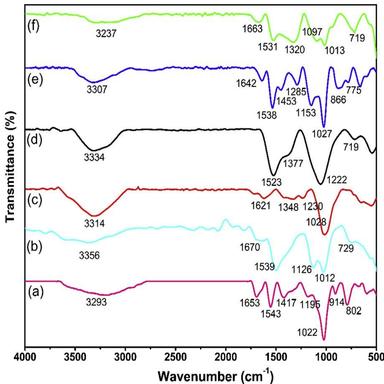
FTIR spectra of (a) PPy/GO, (b) PPy/rGO, (c) MWCNT/GO/NCC (d) MWCNT/rGO/NCC, (e) PGMGN and (f) r-PGMGN.